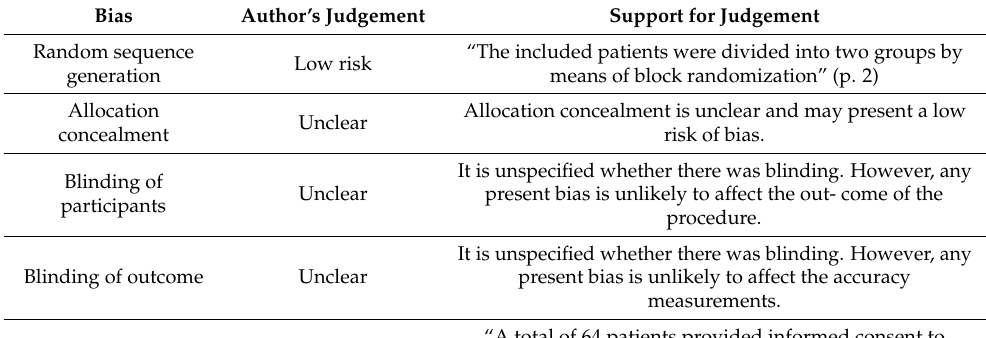
Table A5. Risk of bias analysis of Van der Wel et al. (2022) using Cochrane Collaboration’s risk of bias